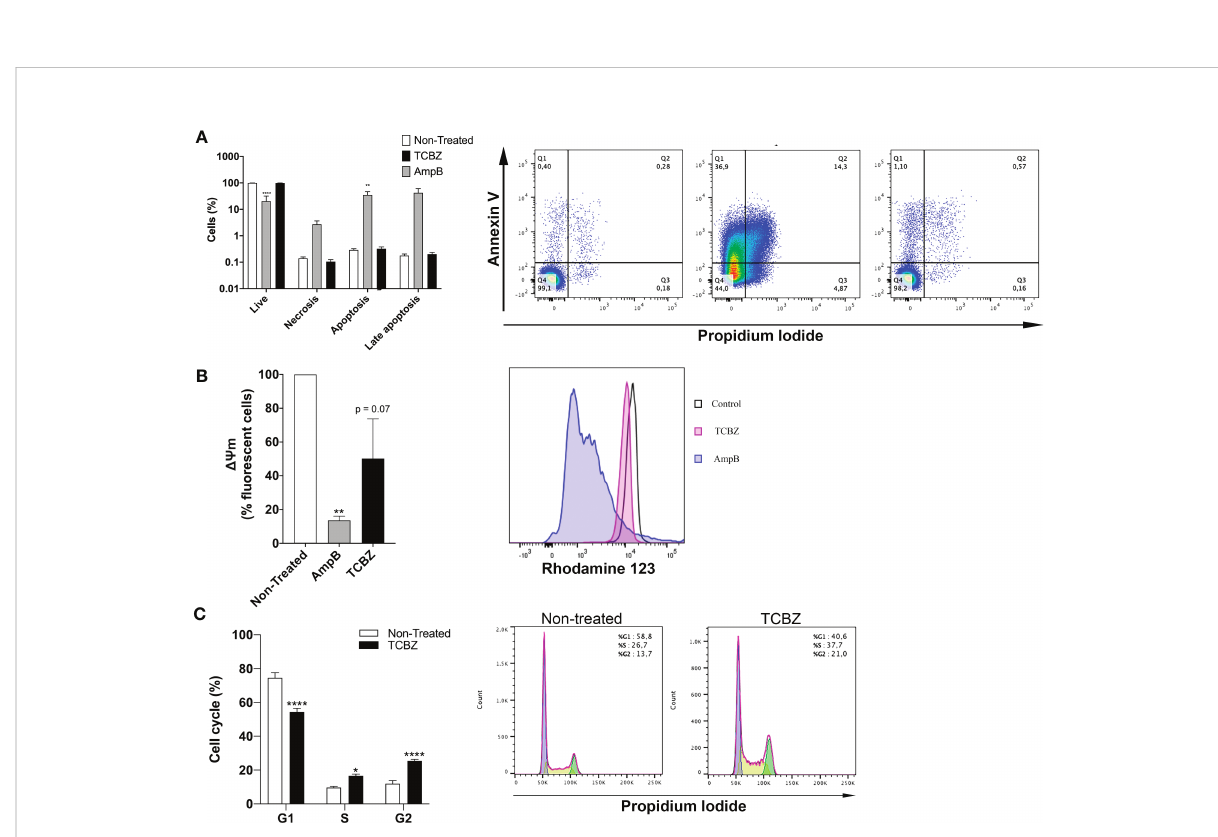
FIGURE 8 Flow cytometer assays in promastigotes treated with IC50 of AmpB and TCBZ for 72h. (A) Cell death evaluation with co-staining of Annexin V and PI of non-treated and TCBZ treated parasites. Typical dot plots of one representative experiment are shown. Q1: apoptosis, Q2: late apoptosis. Q3: living cells. Q4: necrosis. (B) Membrane potential evaluated with Rod123 assay. Typical histograms of one representative experiment are shown. (C) Cell cycle evaluation with PI staining. Typical histograms of one representative experiment are shown. Values are represented in percentage (%) of 10.000 evaluated events. * = p < 0.0332, ** = p < 0.0021, **** = p <